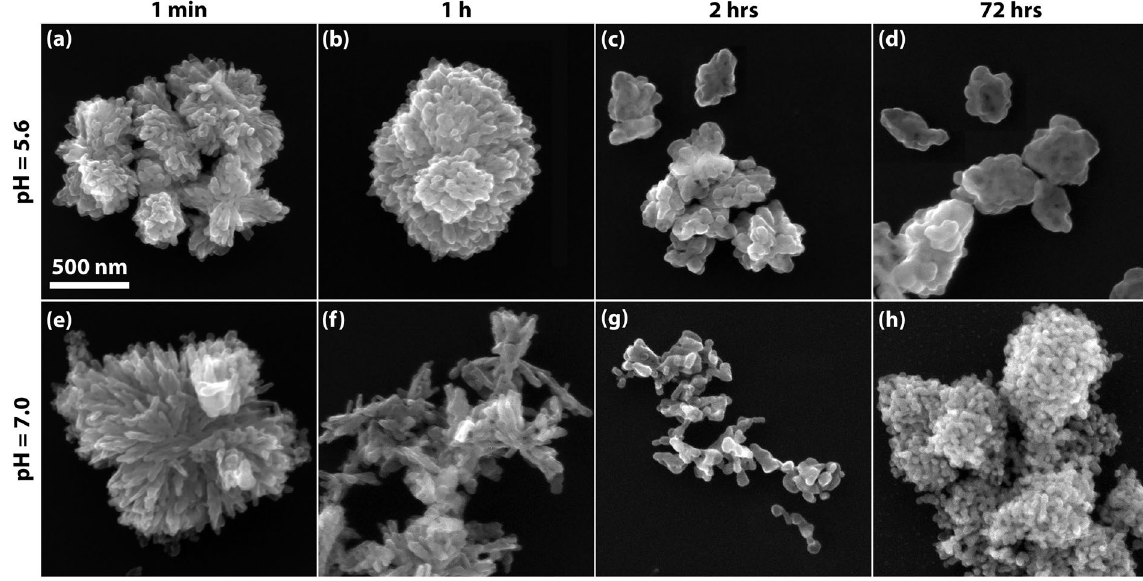
Figure 5. SEM images of CuO nanoparticles synthesized at different pH-values and precipitation (i.e. aging) times of the solution. The aging time of 2 h corresponds to the optimum aging